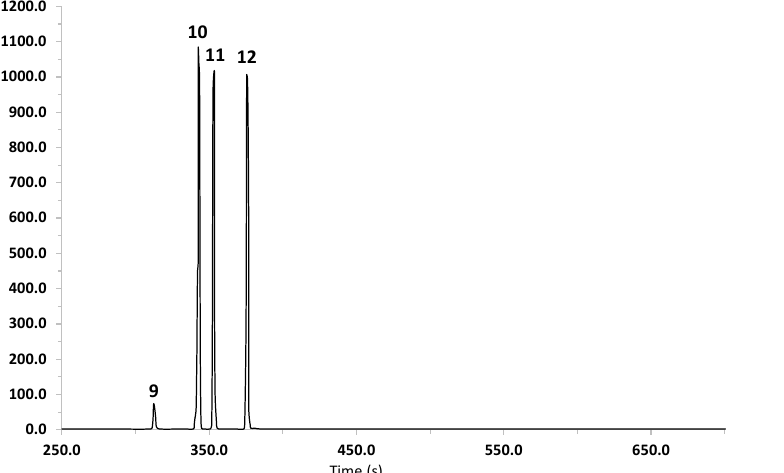
Figure 3. Total ion current chromatogram of the components of the essential oil from B. heterophylla extracted using hydrodistillation. Peaks are: α -pinene ( 9 ), β -pinene ( 10 ), myrcene ( 11 ) and D- limonene ( 12 ).